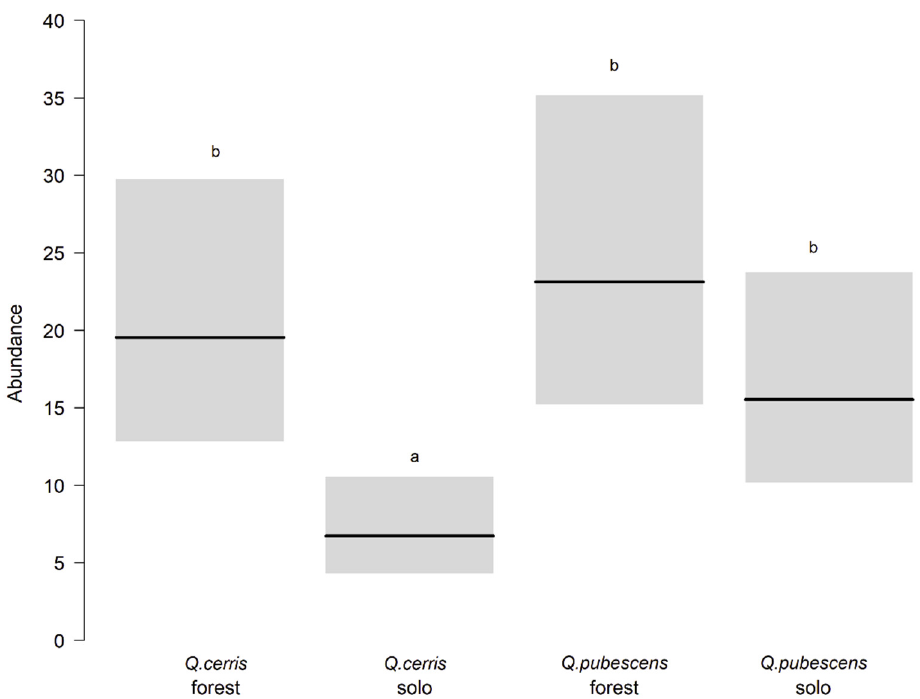
Figure 8. Abundance of Agriopis leucophaearia caterpillars (number of individuals on two branches, each 1 m long) on young LF Quercus cerris and EF Q. pubescens located in the forest interior and on lone (solo) trees in open forest glades or edges. A horizontal line denotes the mean, and bars the 95% confidence intervals. Distinct letters above columns indicate a significant difference.